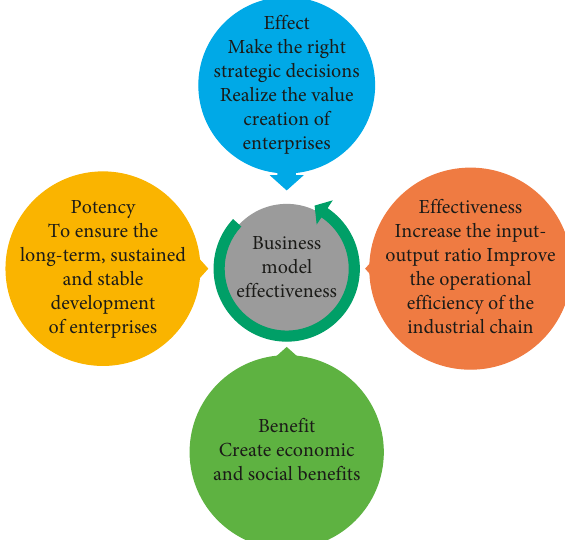
Figure 3: The connotation of an effective technological startups business